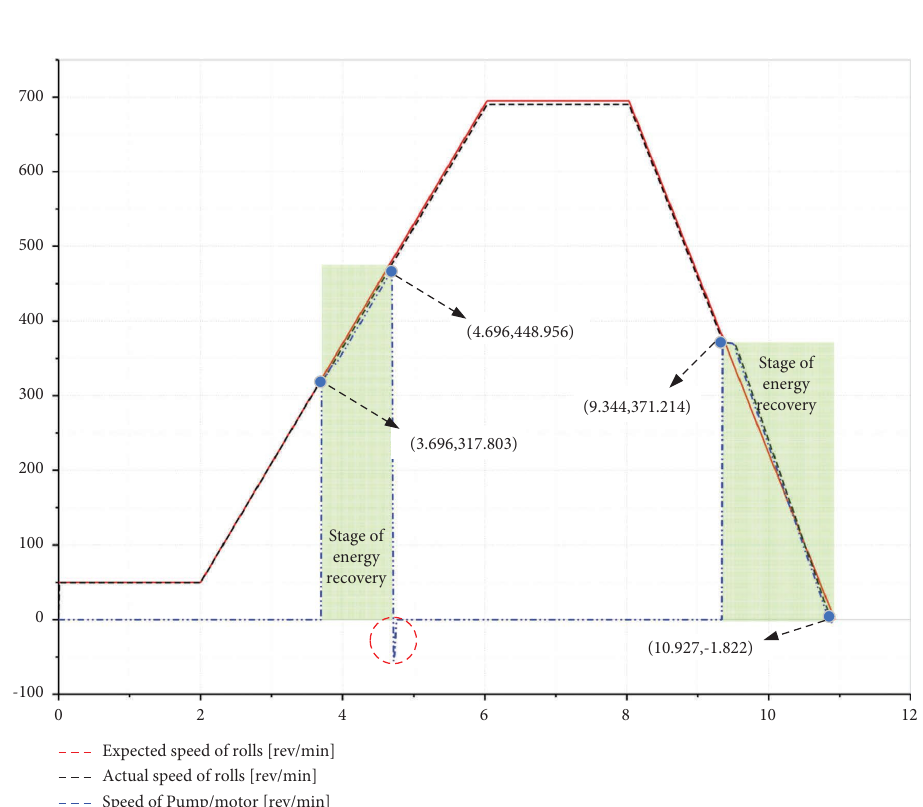
Figure 12: Speeds of the recovery pump/motor, the ideal speed, and the actual speed for the